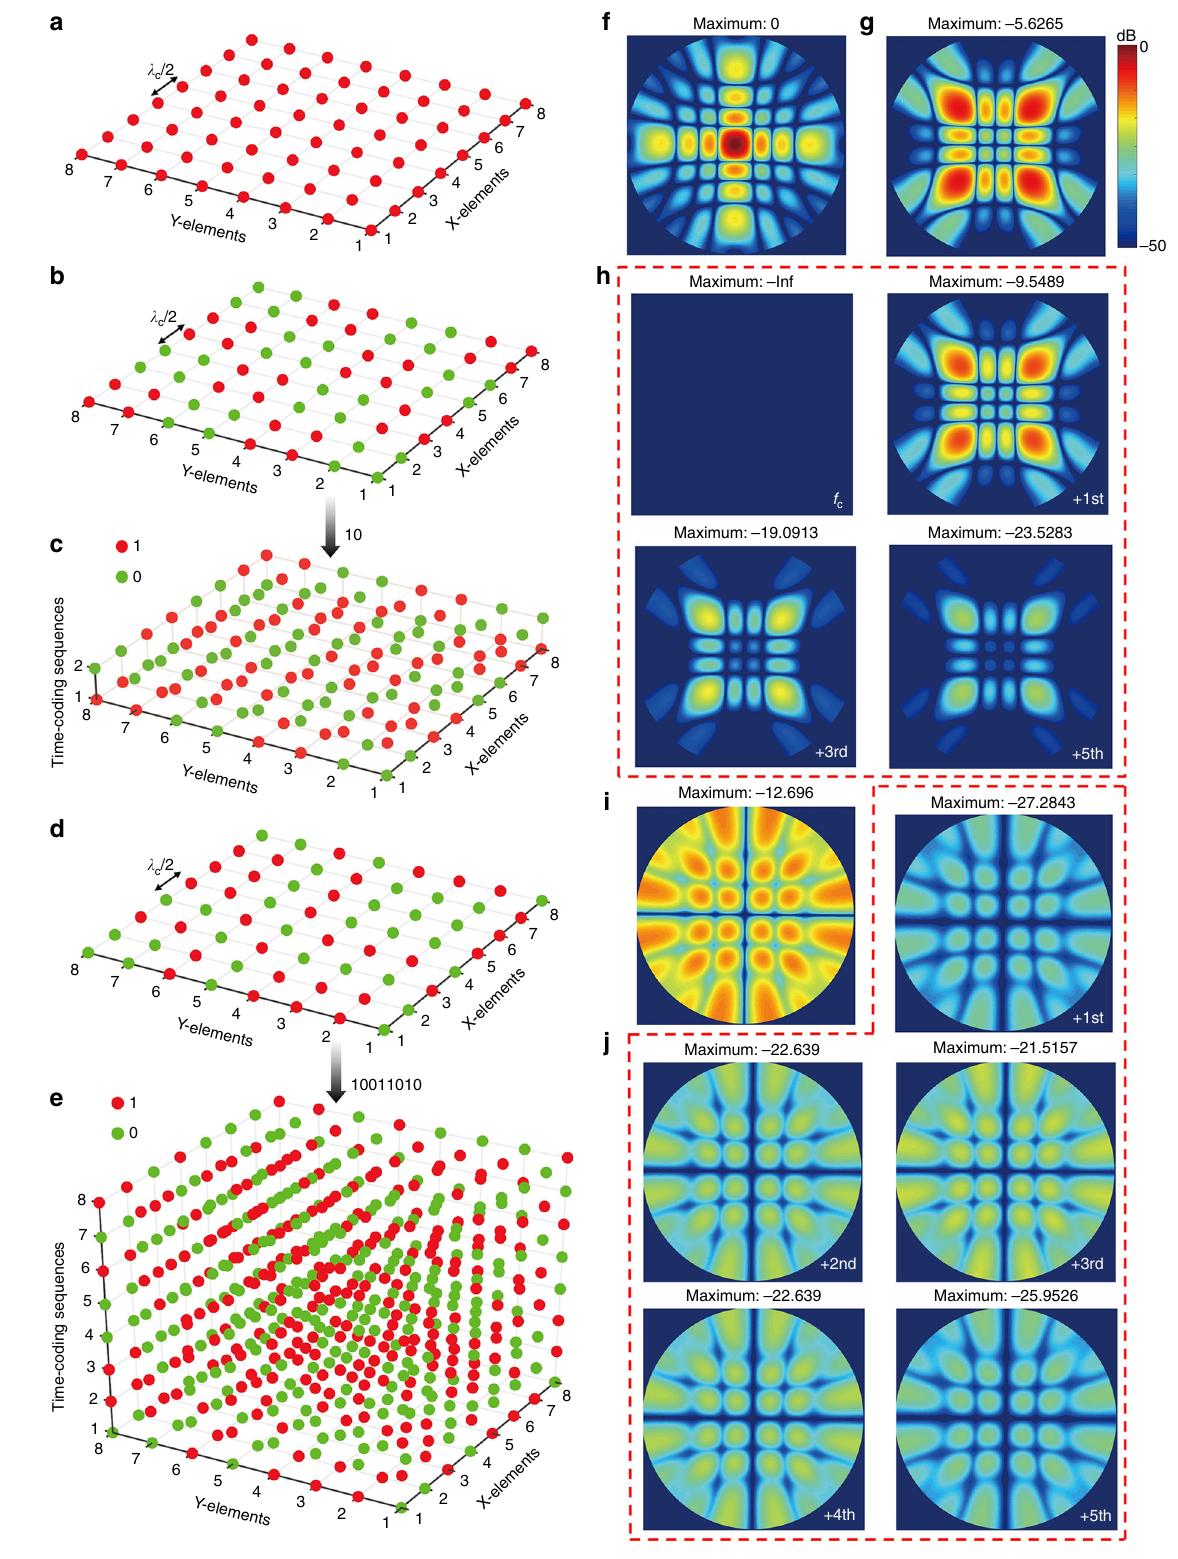
Fig. 5 RCS reductions via space-time-coding metasurfaces. a , b Metasurfaces with uniform and chessboard-like space-coding distributions, respectively. c 3D space-time-coding matrix obtained by applying the time-coding sequence “ 10 ” to the chessboard-like space coding. d Metasurface with an optimized space- coding distribution. e 3D space-time-coding matrix obtained by applying the random time-coding sequence “ 10011010 ” to the space coding in panel ( d ). f , g 2D scattering patterns pertaining to the metasurfaces in panels ( a , b ), respectively. h 2D scattering patterns pertaining to the space-time-coding digital metasurface in panel ( c ) at different harmonic frequencies. Note that this time-coding results in the generation of odd harmonics only. i 2D scattering patterns of the metasurface in panel ( d ). j 2D scattering patterns pertaining to the space-time-coding digital metasurface in panel ( e ) at different harmonic